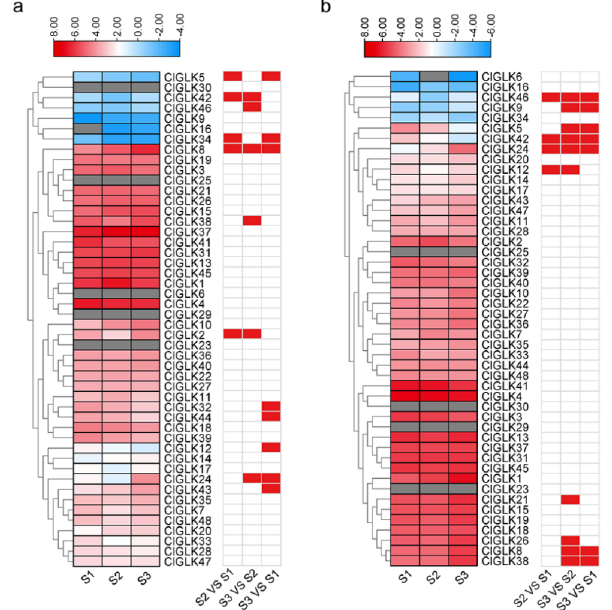
Figure 6 . Expression analysis of ClGLKs in the pericarp of two cultivars of watermelon. ( a ) The expression heatmap of ClGLKs at three stages in the cultivar “W ‐ 21 ‐ 72”. ( b ) The expression heatmap of ClGLKs at three stages in the cultivar “W ‐ 21 ‐ 301”. The red color in the right table represents the DEGs in the transcriptome analysis.